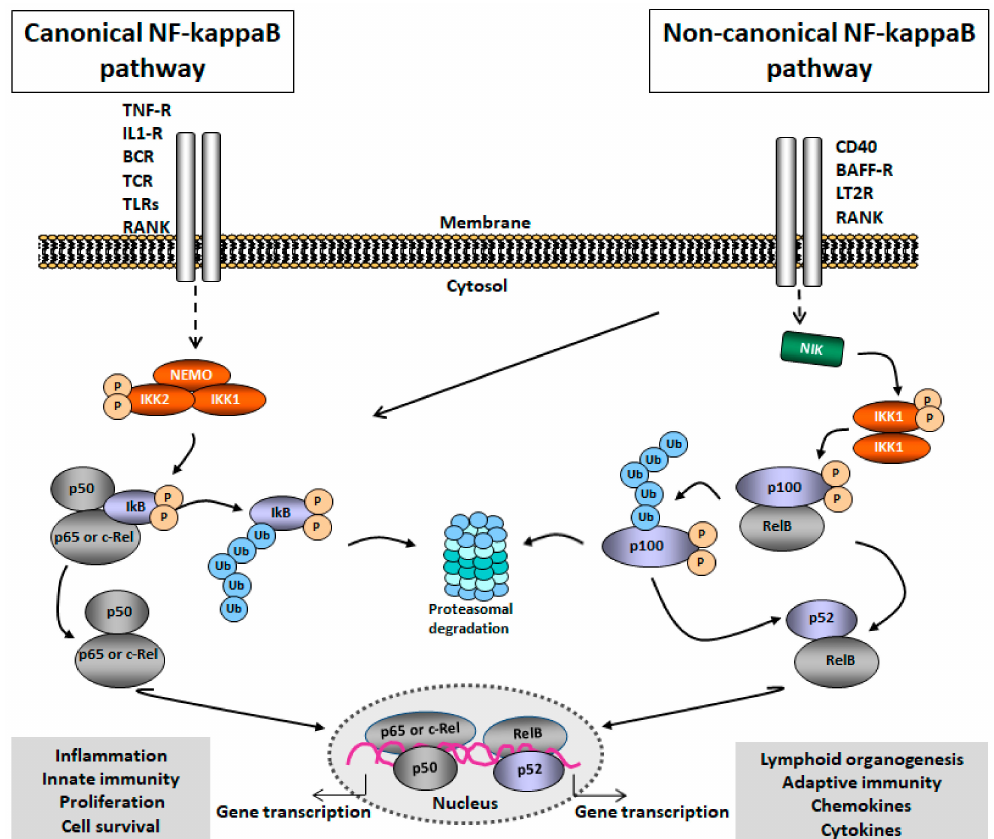
Figure 1. Nuclear factor-kappaB (NF-kappaB) signaling pathway. The canonical pathway (left) is activated through di ff erent receptors including TNF-receptor (TNF-R), IL-1 receptor (IL-1R), B-cell receptor (BCR), T-cell receptor (TCR), Toll-like receptor, RANK, and CD40. IKK / NEMO-induced phosphorylation of IkappB-alpha leads to nuclear translocation of NF-kappaB heterodimers (p50 / p65, p50 / c-Rel) and transcriptional activation of target genes. The non-canonical pathway (right) is activated through CD40, B-cell-activating factor receptor (BAFF-R), lymphotoxin beta receptor (LT2R) and RANK. Processing of p100 leads to the translocation of RelB / p52 heterodimers into the nucleus and activates target-gene